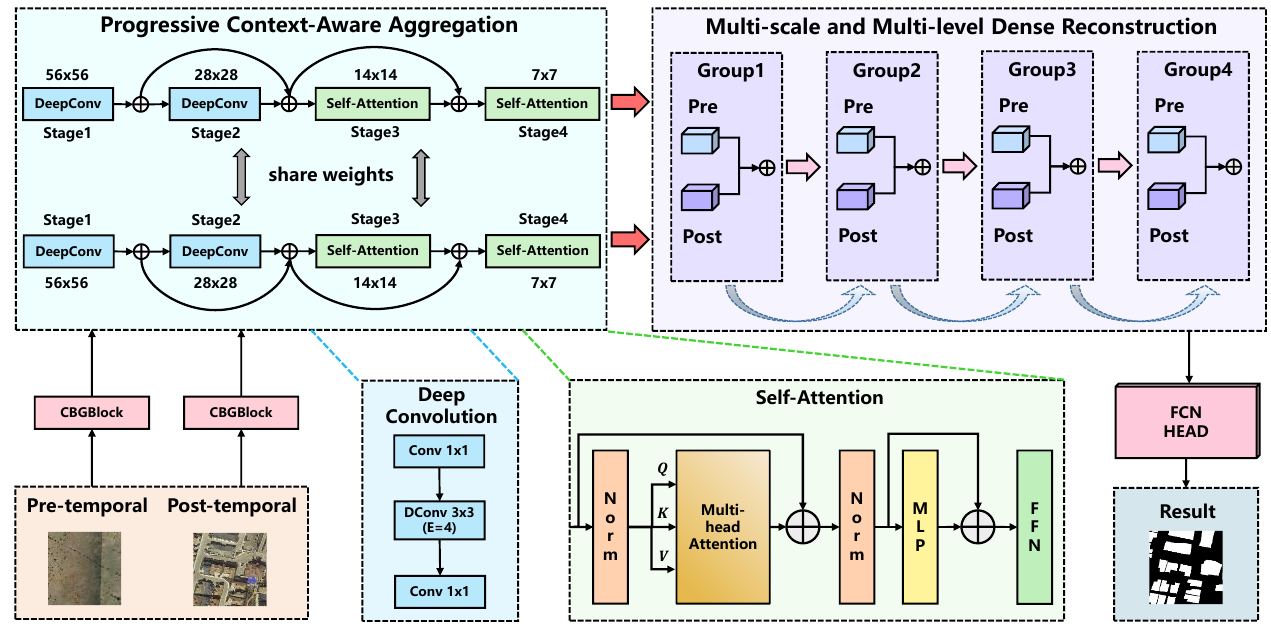
Figure 1. Overview of the proposed method. Firstly, bi-temporal images pass through the CBGBlock, which increases the number of channels while ensuring image resolution. After that, our progressive context-aware aggregation module utilizes deep convolution to extract local features, while self-attention is used to derive global features based on local features. The MMDR module can group the extracted sequential feature information and intensively connect it to the corresponding feature information. Finally, our FCN prediction head outputs the BCD